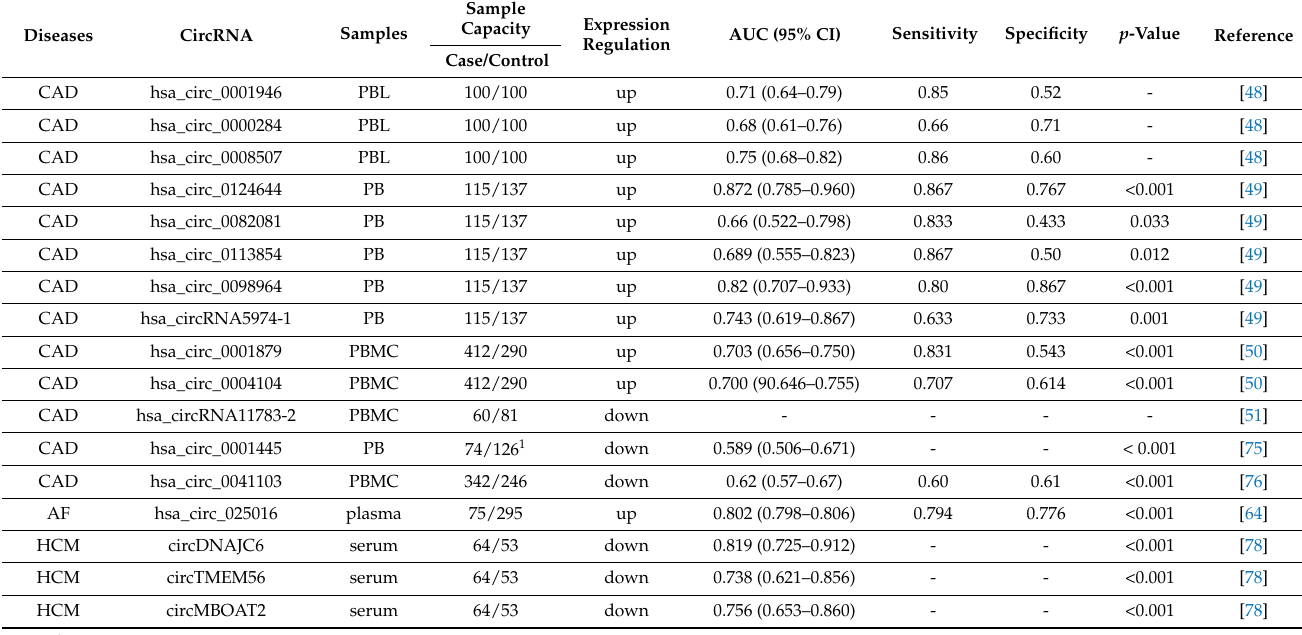
Table 2. The diagnosis value of circRNAs in SCD related